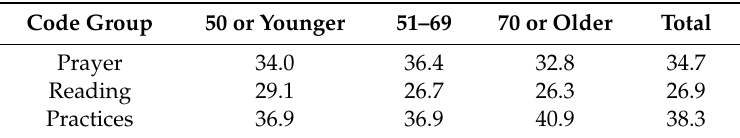
Table 2. Code groups and personal context—age. Code Group